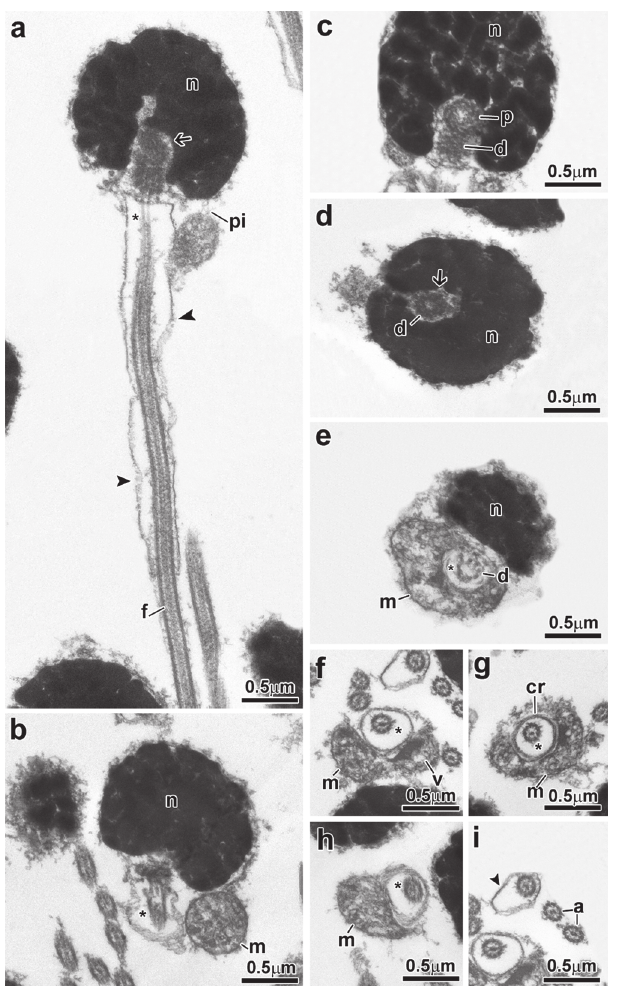
Fig. 4. Spermatozoon of Brachypetersius altus . a, b, c: longitudinal sections. d, e, f, g, h, i: transverse sections from top to posterior region. The nucleus (n) is spherical and lies medial to the flagellum (f). The centriolar complex (p, d) and nuclear fossa (arrow) is medial. The proximal centriole (p) is in a right angle relative to the distal centriole (d). The cytoplasmic canal is present (asterisk). The midpiece (pi) is asymmetrical, and contains the branched or “c” shape mitochondria (m), vesicles (v) and a cytoplasmic sleeve (arrowhead). Legends: a: axoneme, cr: concentric membranous rings, d: distal centriole, f: flagellum, m: mitochondria, n: nucleus, p: proximal centriole, v: vesicle, asterisk: cytoplasmic canal, arrow: nuclear fossa, arrowhead: cytoplasmic sleeve.